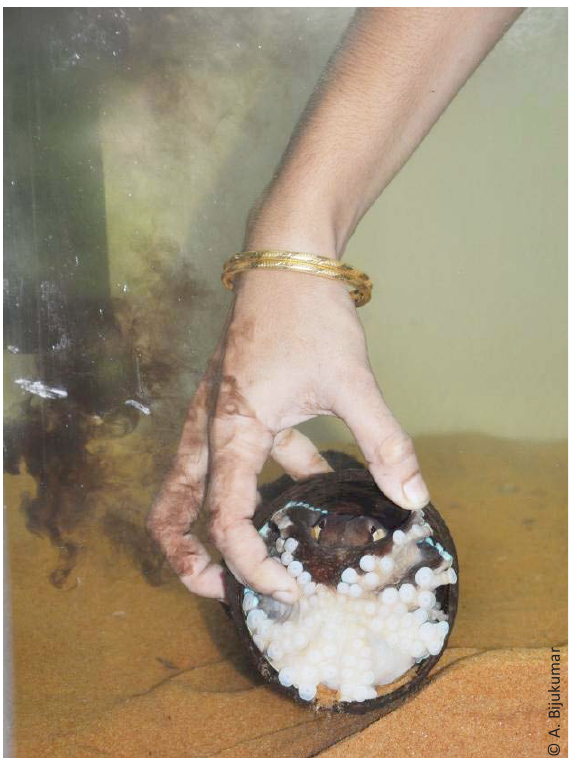
Image 12. A. marginatus (female) releasing ink while selected for removing the festoons